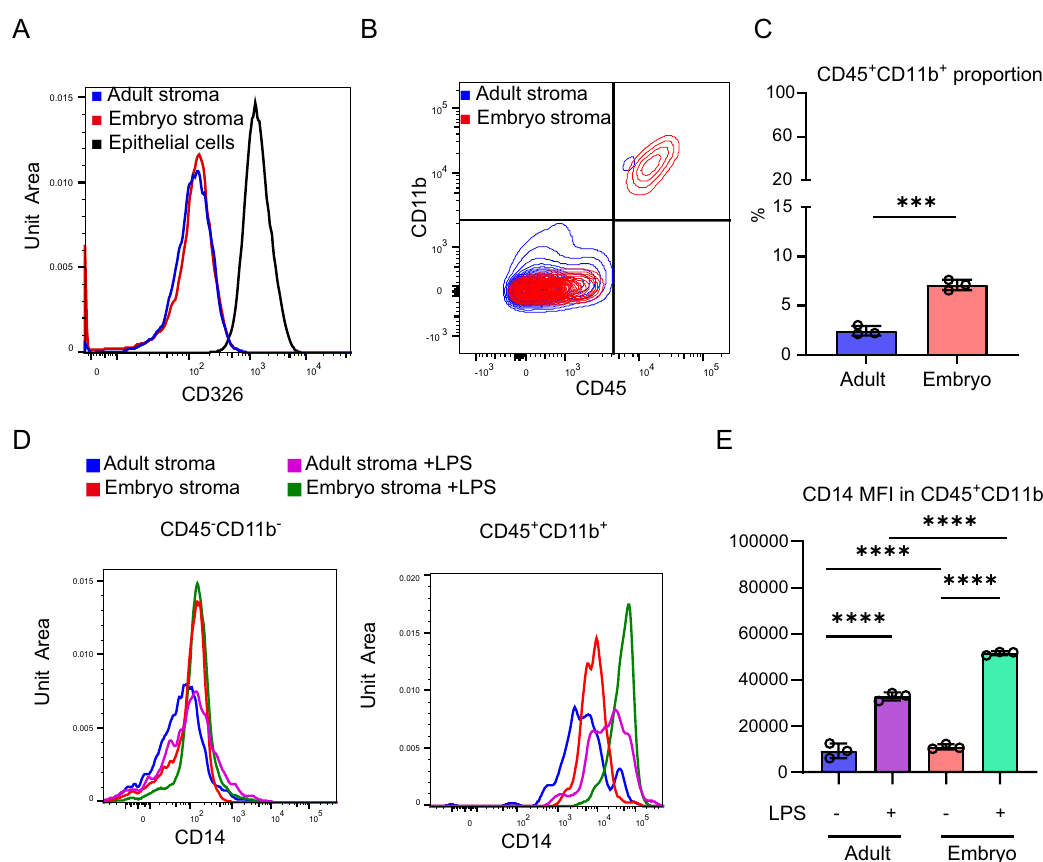
Figure3. CD14 is upregulated in CD45 + CD11b + leukocytes in the embryonic stroma following LPS stimulation. ( A ) Histogram showing CD326 expression in primary adult or embryonic intestinal stromal cells, with intestinal epithelial cells as a positive control. Data representative of n = 3 independent cultures generated from 3 adult mice or 3 litters of 6 embryos each. ( B , C ) Flow cytometric analysis of CD45 and CD11b expression in adult or embryonic intestinal stromal cells. The percentage of live CD45 + CD11b + cells were compared. n = 3 biological replicates. t-test ***p < 0.001. ( D ) Histogram depicting CD14 expression in CD45 - CD11b − or CD45 + CD11b + populations in adult or embryonic intestinal stromal cells treated with LPS or vehicle control. ( E ) CD14 mean fluorescence intensity (MFI) in CD45 + CD11b + gated adult or embryonic intestinal stromal cells treated with LPS or vehicle. n = 3 biological replicates. One way ANOVA with Tukey’s multiple test. ****p <